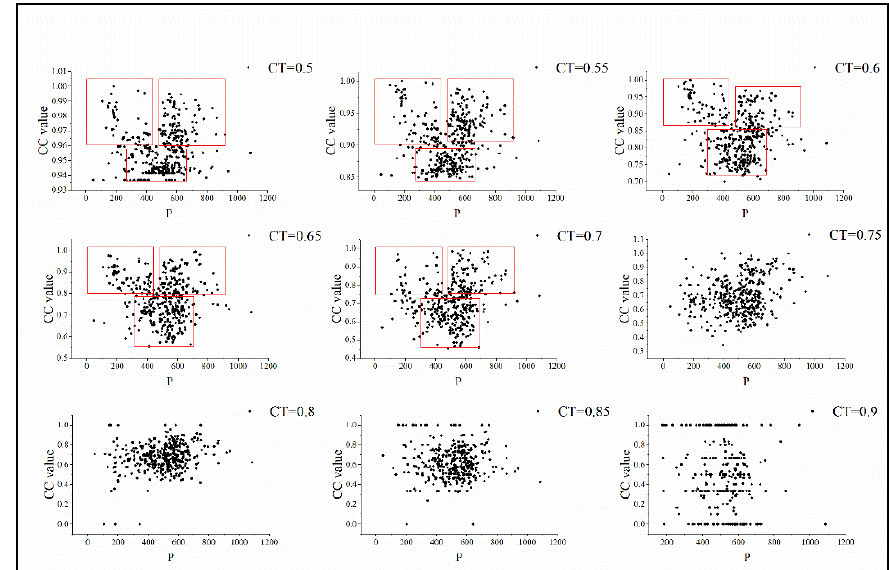
Figure 4. The clustering coefficient values versus annual average precipitation.